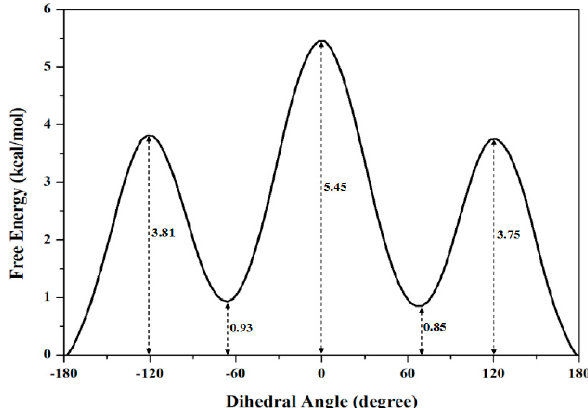
Figure 3. The calculated PMF profile for the rotational transition of butane from − 180° to 180° with the relative energy values along the coordinate of dihedral angles. The numbers around the dash lines are the relative energy values at the corresponding angles.